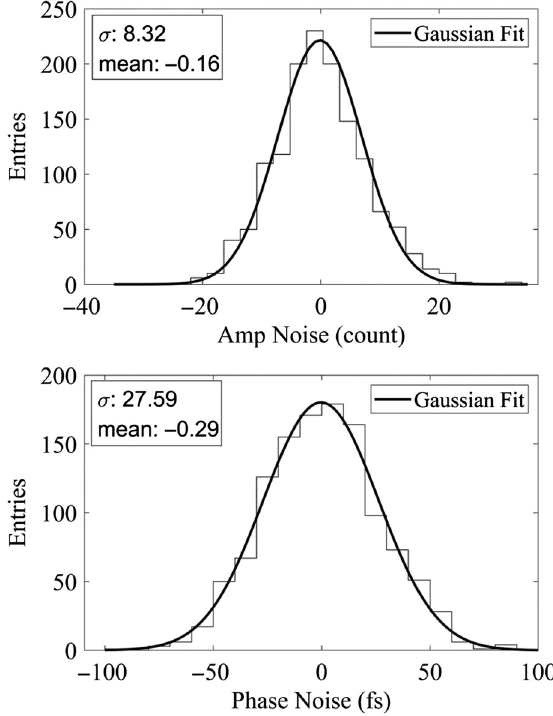
FIG. 9. Phase and amplitude errors of the electronics with a constant rf input.